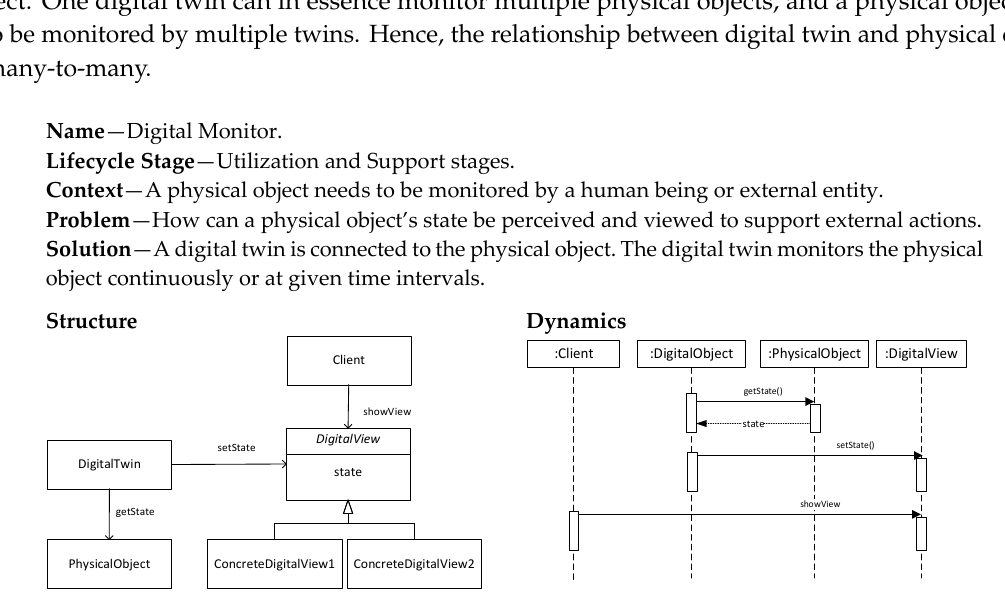
Figure 12. Digital Restoration pattern.